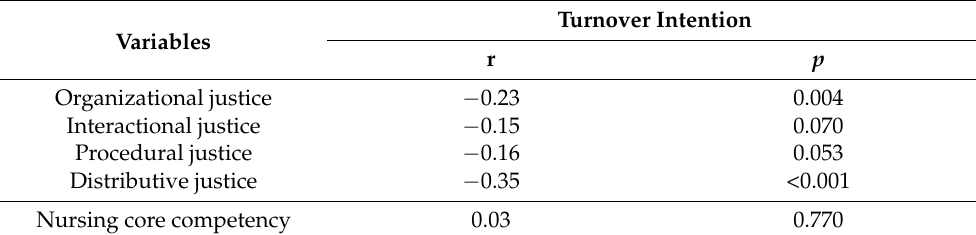
Table 3. Correlations between turnover intention, organizational justice, and nursing core competency ( N =